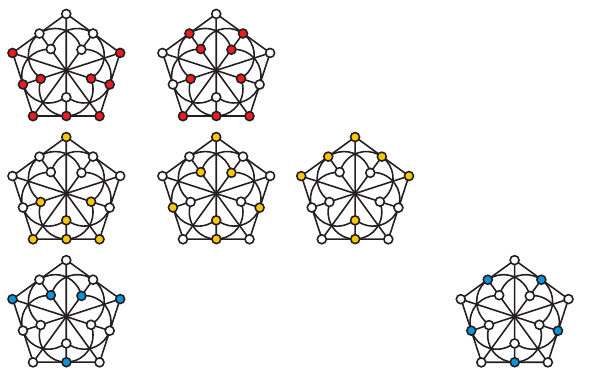
Figure 1. The three kinds of geometric hyperplanes of W ( 3,2 ) . The 15 points of the doily are represented by small circles and its 15 lines are illustrated by the straight segments as well as by the segments of circles; note that not every intersection of two segments counts for a point of the doily. The upper panel shows grids (red bullets), the middle panel perp-sets (yellow bullets) and the bottom panel ovoids (blue bullets). Each picture—except that located in the bottom right-hand corner—stands for five different hyperplanes, the four others being obtained from it by its successive rotations through 72 degrees around the center of the